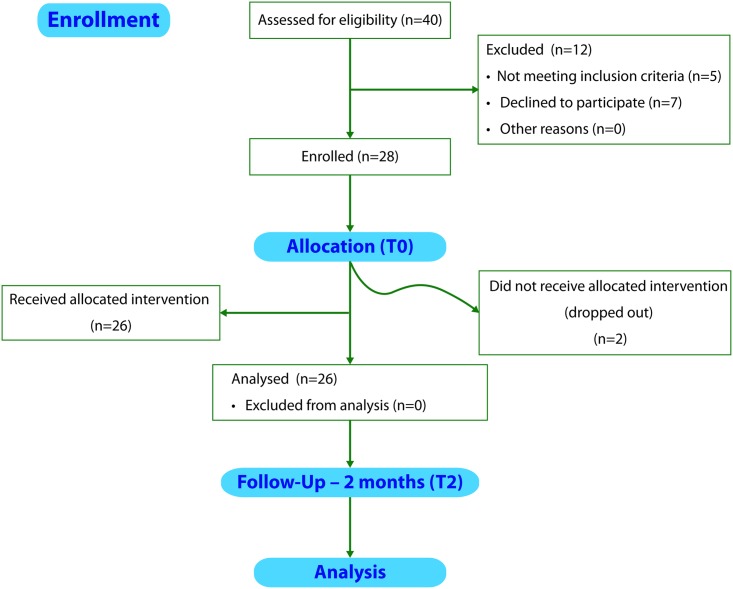
Study flow diagram.Graphical study representation, adapted from CONSORT® 2010 flow diagram, showing the total number of people assessed for eligibility, enrolled, undergoing intervention and analyzed.